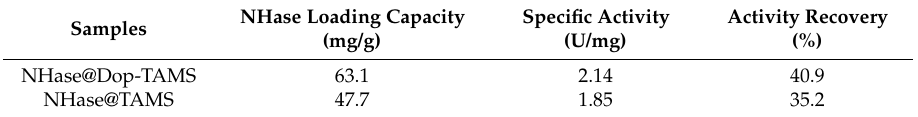
Table 1. The enzyme loading capacities and activities of NHase@TAMS and NHase@Dop-TAMS.